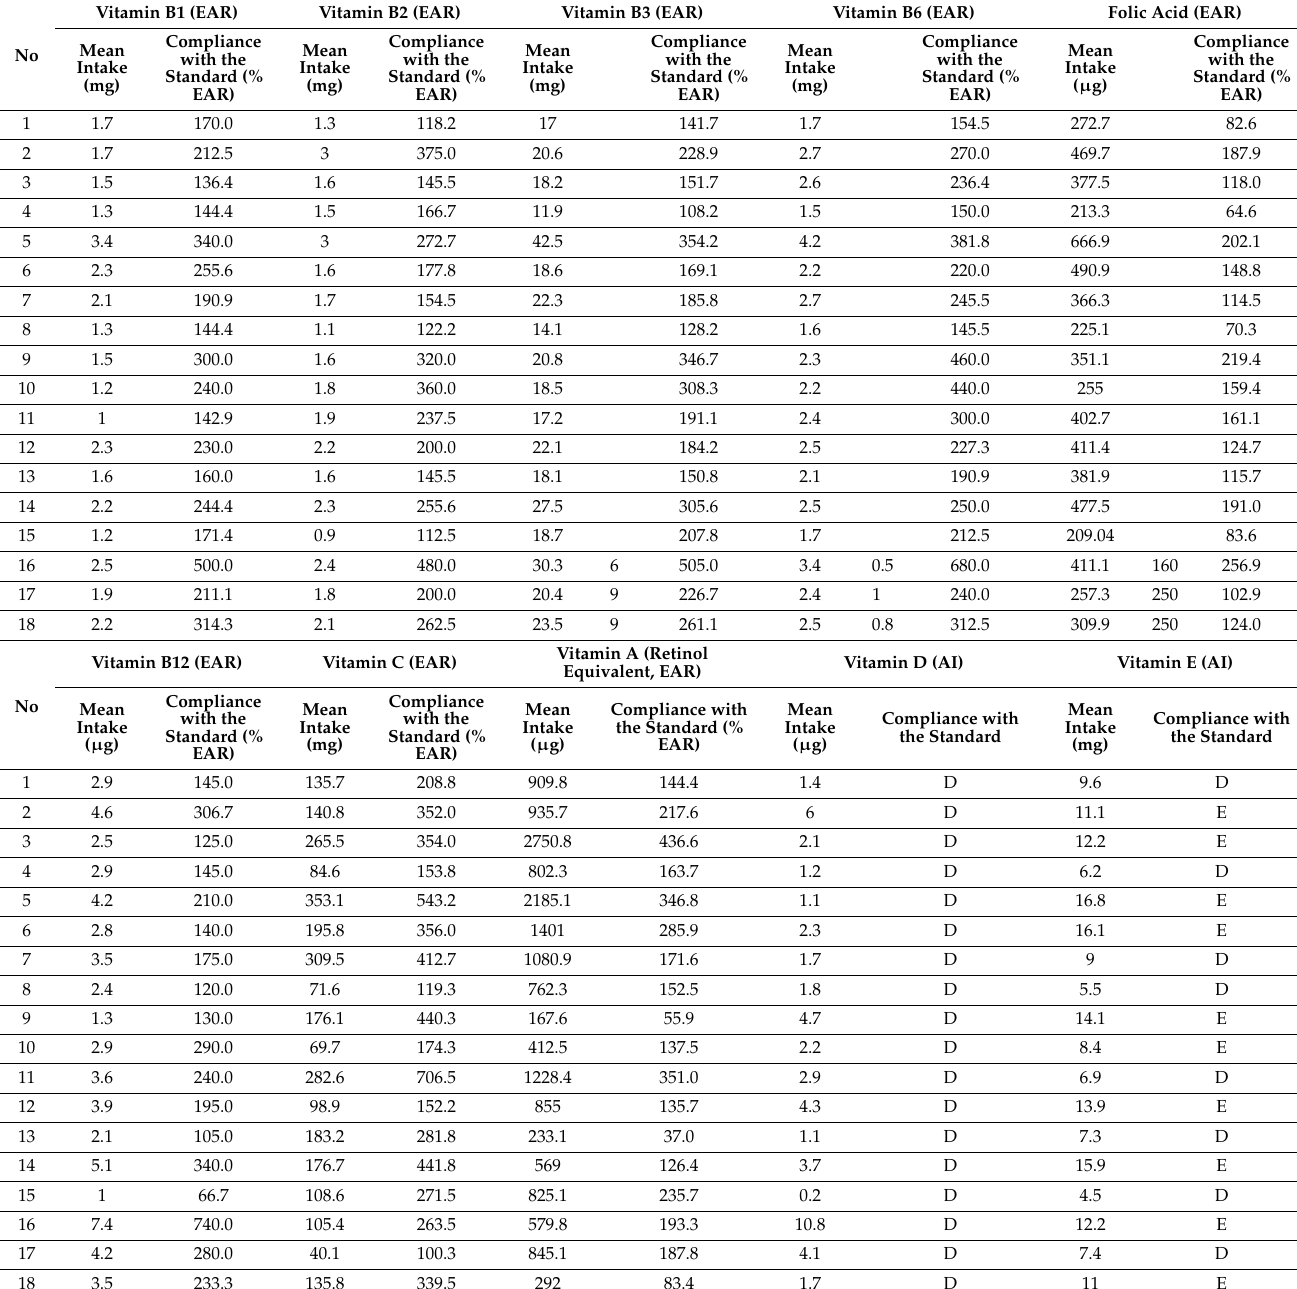
Table 5. Dietary intake of selected vitamins with DFRs among people with